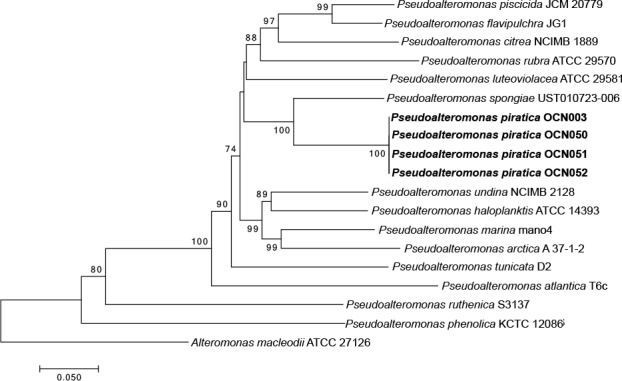
Neighbor-joining dendrogram showing the estimated phylogenetic relationships between the Pseudoalteromonas piratica strains OCN003 (type strain), OCN050, OCN051, OCN052 (strains isolated during the 2010 aMWS outbreak), and related Pseudoalteromonas spp. based upon a multi-locus sequence analysis.Analysis was based on the sequences of the housekeeping genes recA, gapA, and ftsZ. Alteromonas macleodii ATCC 27126 was chosen as the outgroup. The scale bar represents five nucleotide substitutions per 100 nucleotides. Bootstrap values >70% (500 replicates) are indicated at nodes.